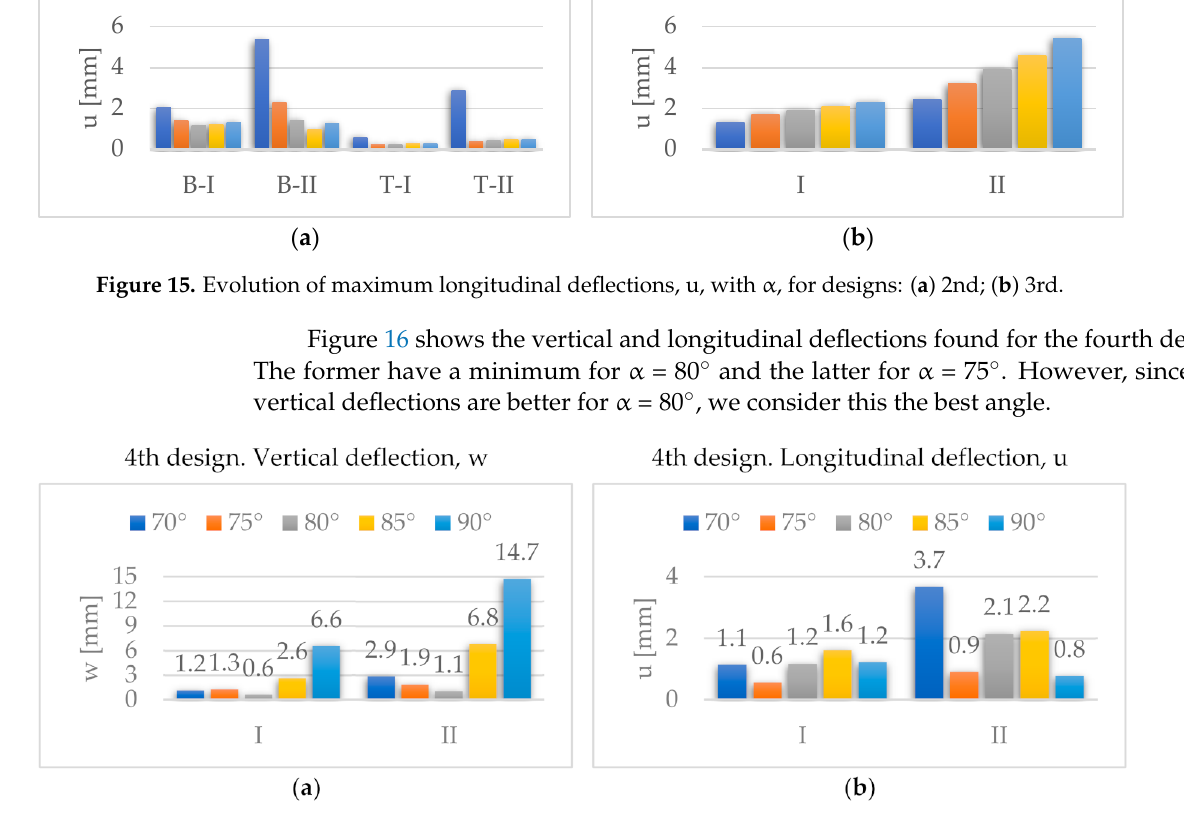
Figure 16. Evolution of maximum deflections with α , for the 4th design: ( a ) w; ( b ) u. Figure 17 shows the stress distributions σ xx and σ yy in the global reference system for the fourth design. For both orientations, σ xx and σ yy a lso present a minimum for α = 80°.